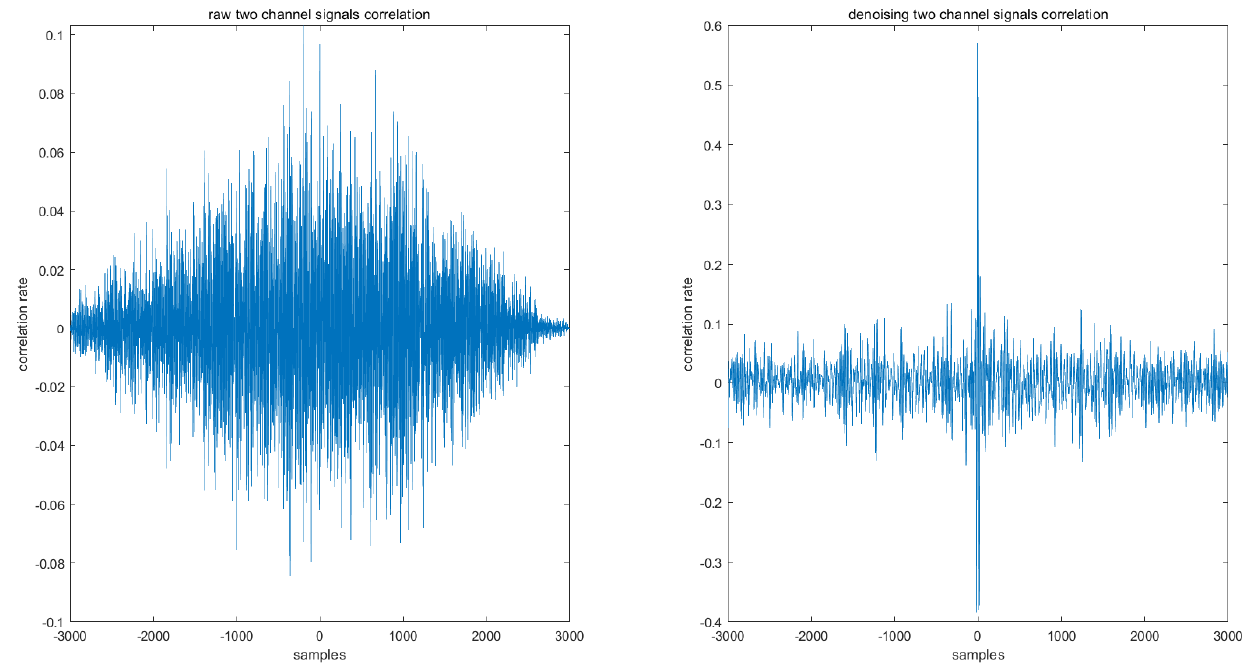
Figure 5. The correlation between the two channels.